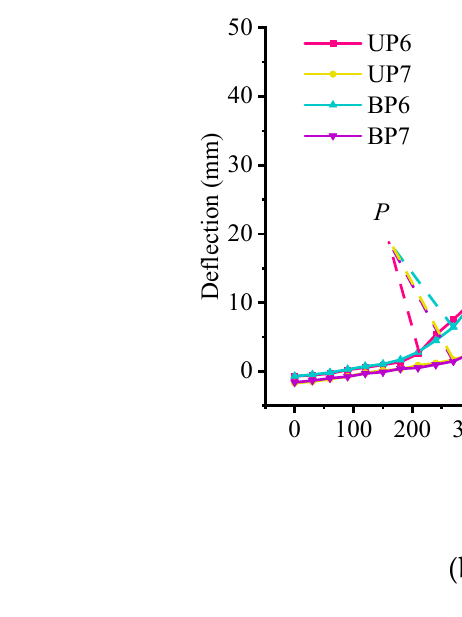
Figure 7. The influence of steel strand reinforcement ratio on mid ‐ span deflection: ( a ) the influence of non ‐ prestressed reinforcement ratio on deflection; ( b ) the influence of prestressed steel strand reinforcement ratio on the deflection.